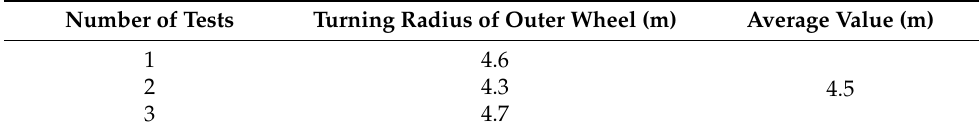
Table 11. Turning radius